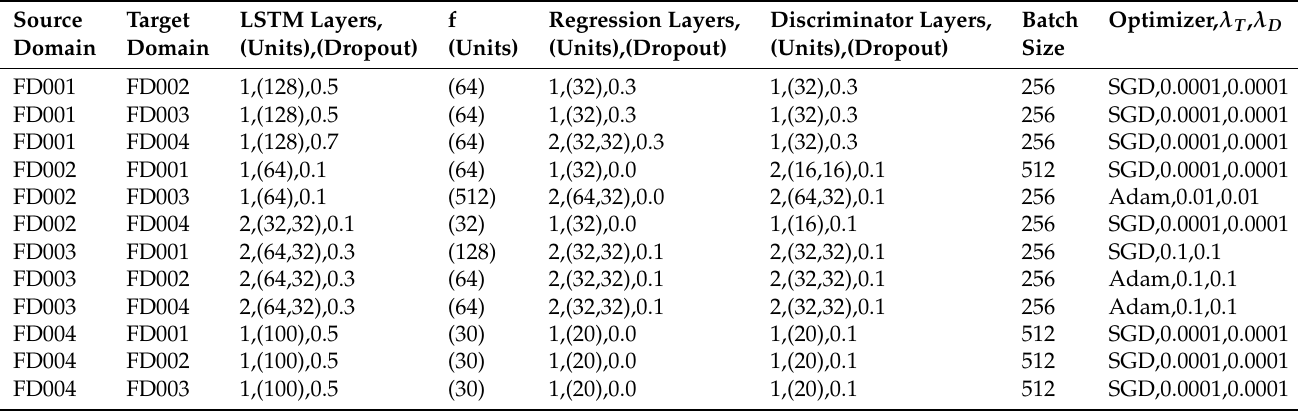
Table 2. Hyperparameter settings for each group of cross-domain